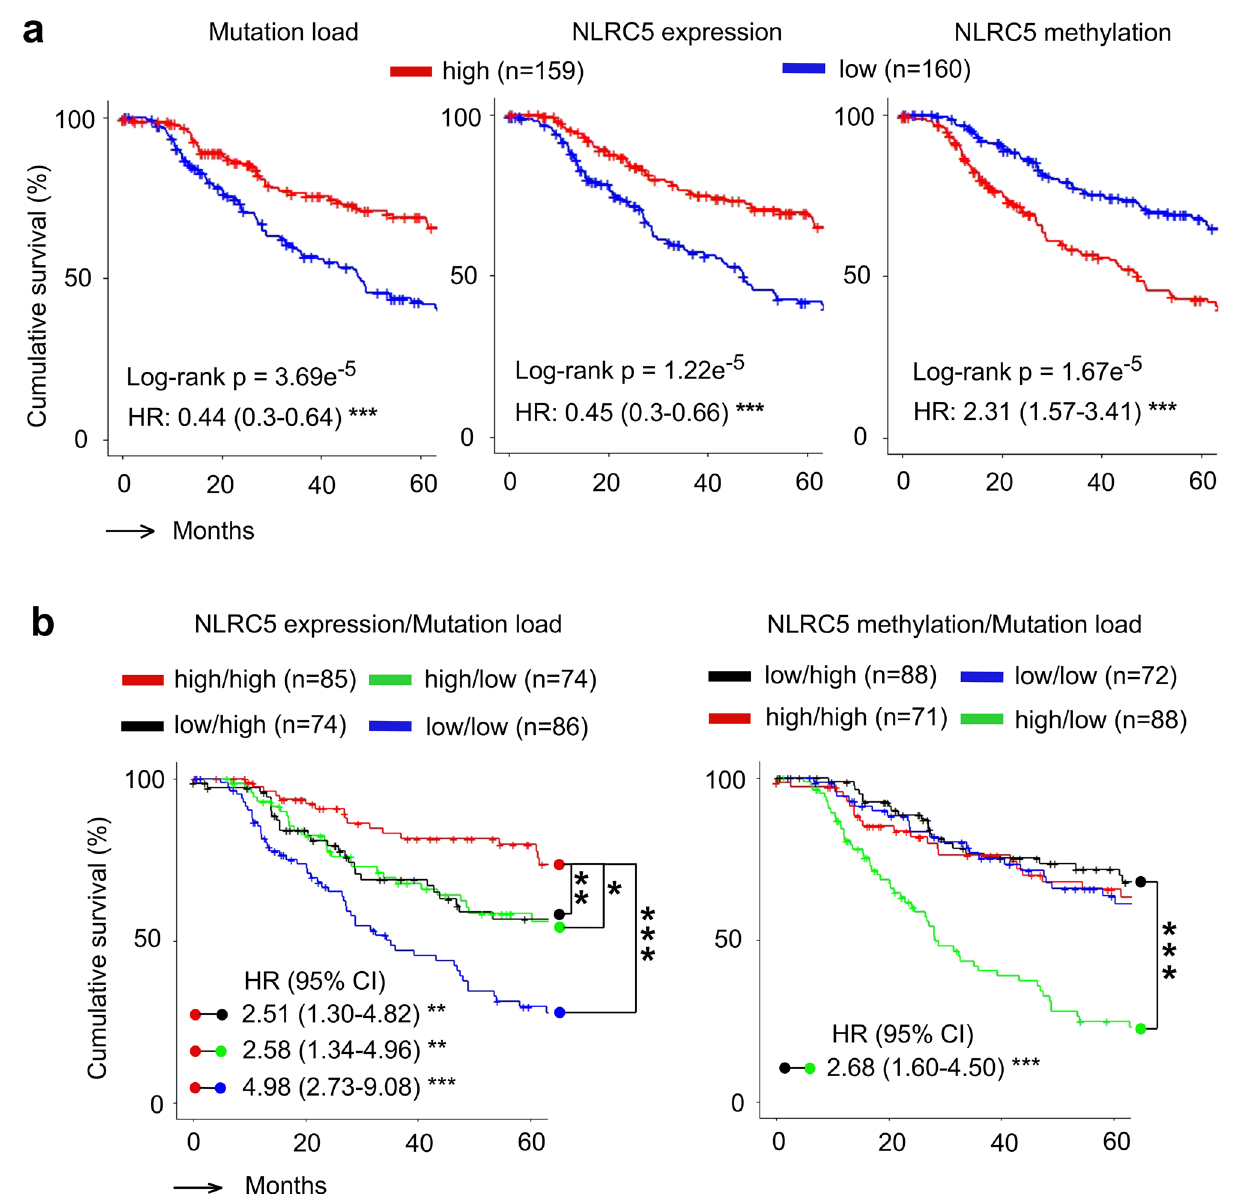
Figure 4. Combination of NLRC5 expression and load of mutation or neoantigen provide prognostic information. ( a ) Kaplan–Meier estimates of five year overall survival of patients with high and low mutation load (Left), NLRC5 gene expression (Middle), and NLRC5 methylation (Right). Patients in the TCGA melanoma cohort were stratified by medians into high and low groups (n = 159 and n = 160). ( b ) Kaplan–Meier estimates of five year overall survival of patients with varying levels of two factors, NLRC5 expression and mutation load (Left) and NLRC5 methylation and mutation load (Right). Patients were stratified by two factors ( NLRC5 expression/ NLRC5 methylation and mutation load) in a similar fashion with ( a ), yielding four groups (high NLRC5 expression/ NLRC5 methylation and high mutation load, likewise, high and low, low and high, low and low). Pairwise log-rank test was used to analyze the survival in indicated pairs. Hazard ratio (HR) and 95% confidence interval (CI) was determined by multivariate analysis using Cox regression model (see Methods). *p < 0.05; **p < 0.01; ***p < and mutation numbers demonstrated better AUC values and a lower false positive rate at 100% sensitivity (Fig. 2d). These data indicate that the combination of NLRC5 /mutation load is superior to these variables alone in identifying non-responders. In contrast to the low correlation between NLRC5 expression and mutation load, the expression of CTLA-4 , PD-1 , PD-L1 or PD-L2 relative to NLRC5 expression carry high to intermedi- ate correlation (Pearson’s coefficient 0.70, 0.83, 0.44 or 0.54, Fig. S3). It appears that PD-L2 is the best variable to combine with NLRC5 and mutation number for purposes of prediction (Table S1) and is in line with PD-L2 being a predictive marker in anti-PD-1 checkpoint therapy 47 . Future discovery of other variables will further